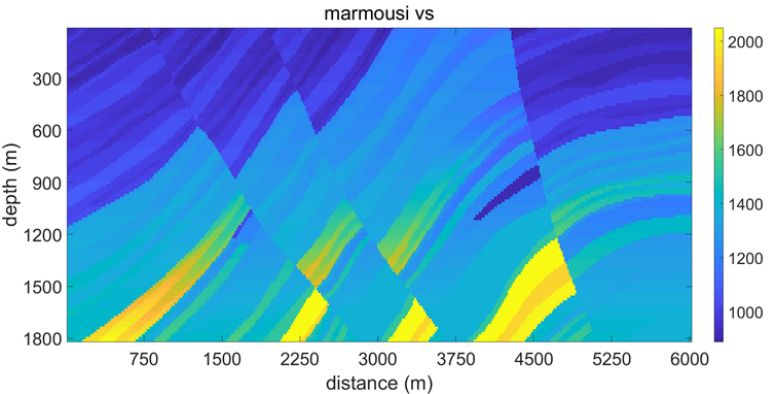
Figure 12. Marmousi model: shear ‐ wave velocity model.